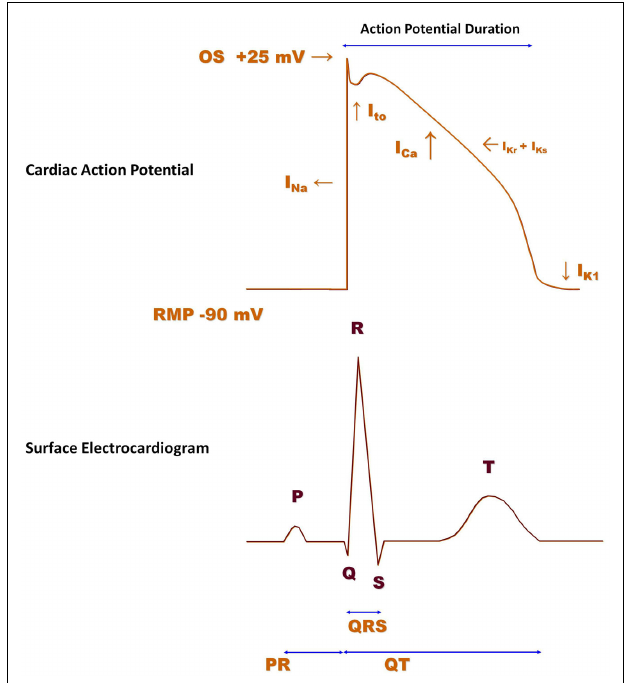
FIGURE 6 | Human ventricular action potential and surface electrocardiogram (ECG). The ventricular action potential (indicated in red) is determined by the activity of several ion channels.When the membrane potential reaches a threshold value, voltage-gated sodium channels (INa) rapidly activate and sodium ions enter the cell down their concentration gradient to cause cell depolarization. INa (Nav1.5), therefore, contributes to the upstroke of the action potential. Following depolarization, calcium channels (ICa; Cav1.2) open to allow calcium ions to enter the cell and initiate the excitation–contraction coupling mechanism. In order to bring the cell back to its resting state, different potassium channels, such as Ito (Kv4.2/Kv4.3), IKr (Kv11.1; HERG), IKs (Kv7.1/mink), and IK1 (Kir2.1) become engaged at different phases of the action potential.The action potential duration represents the time interval between the action potential upstroke and return to the resting level.The surface ECG (purple) is the sum of action potentials over all compartments of the heart.The P wave corresponds to atrial depolarization, whereas the QRS complex is caused by depolarization of the ventricle.TheT wave corresponds to repolarization of the